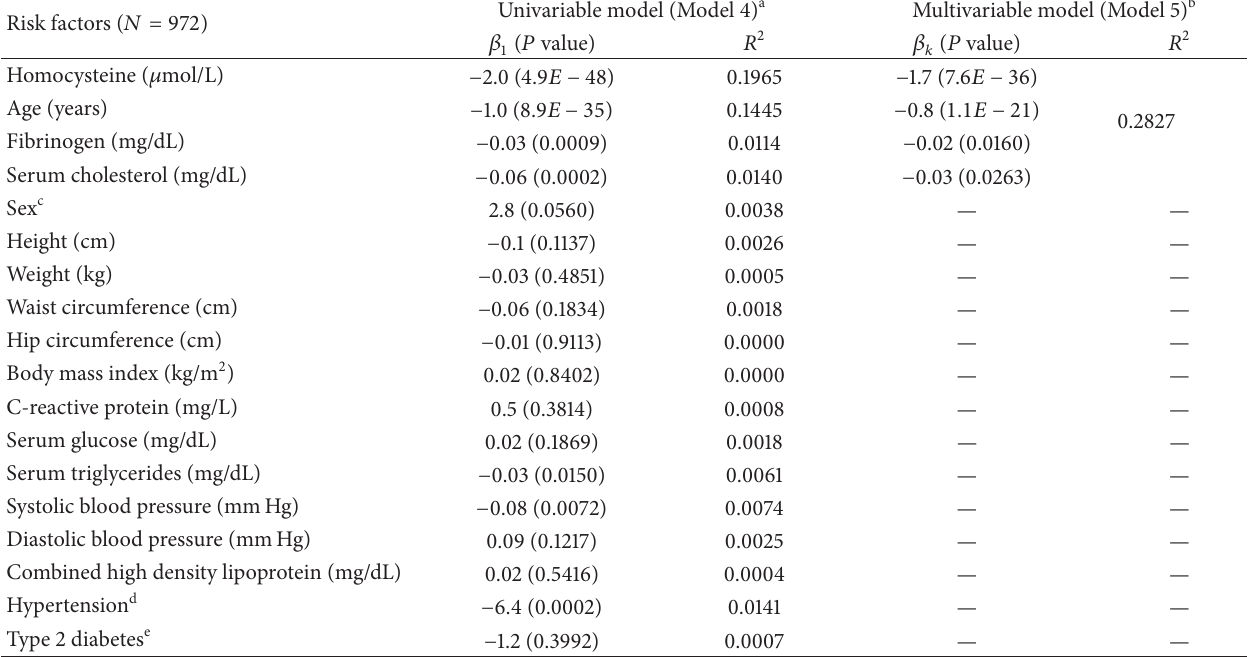
Table 3: Univariable and multivariable linear regression for